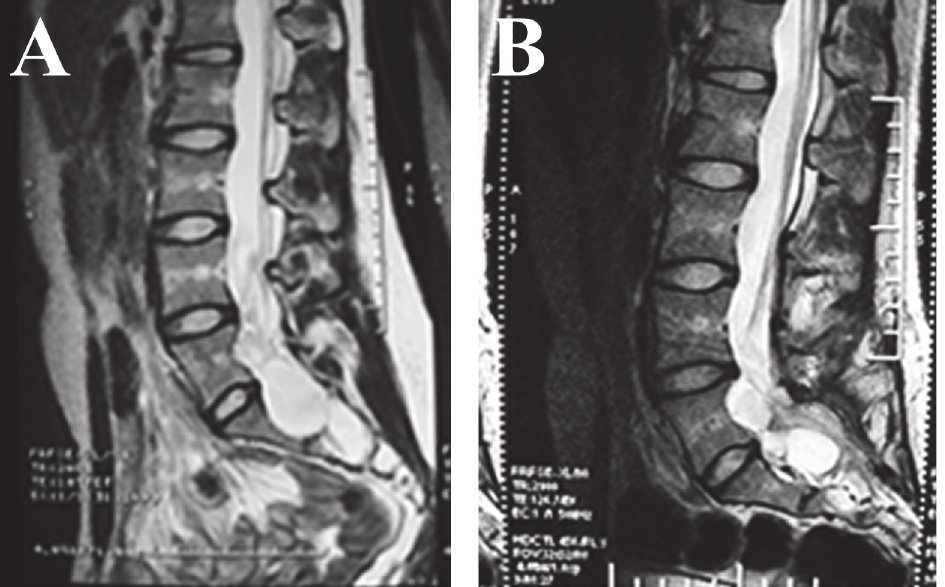
Fig 3. MRI study of shrinkage of the cyst. A. Sagittal T2WI MRI shows multiple cysts before fibrin gel therapy. B. Sagittal T2WI MRI obtained 18 months after operation shows that the cysts became smaller but did not disappear completely.